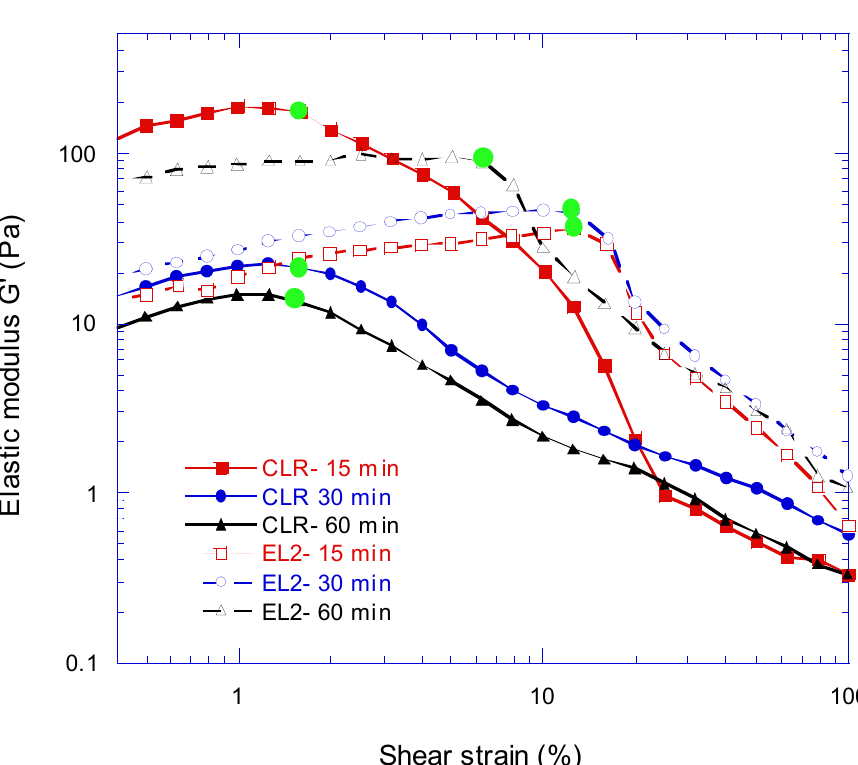
Figure 2. The storage modulus versus shear strain for EL2 synthetic and CLR bio-based epoxies at different time points after mixing of the hardener.